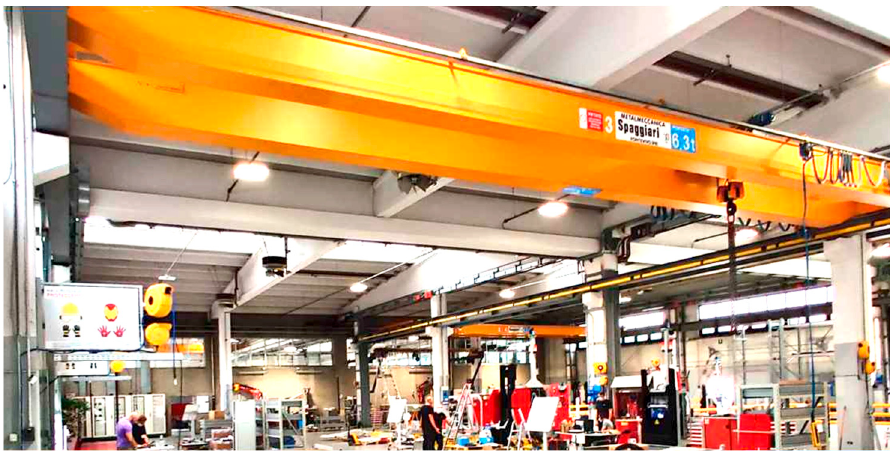
Figure 16. A view of the warehouse used for testing activities.